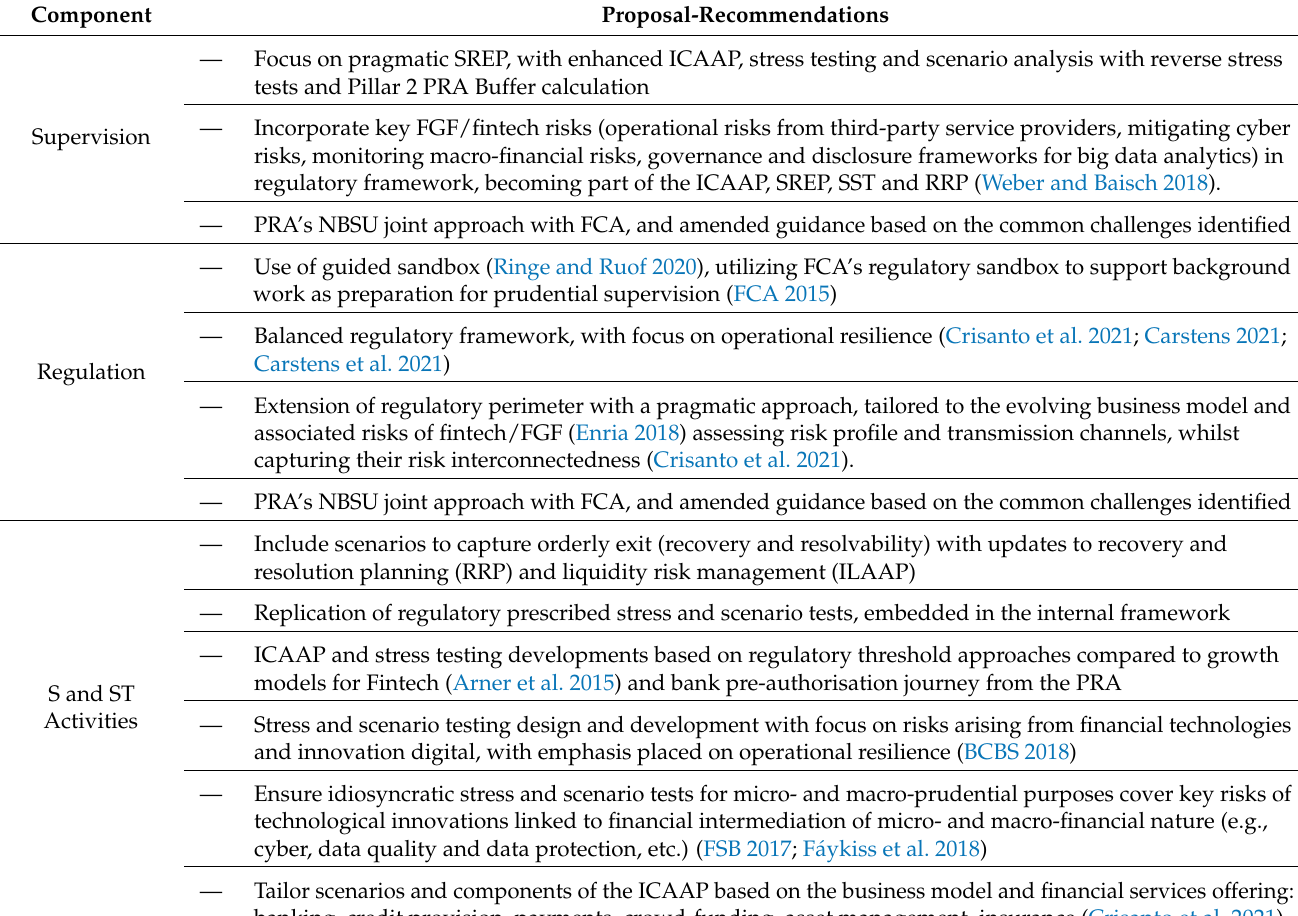
Table 5. List of Recommendations for Fintech Prudential